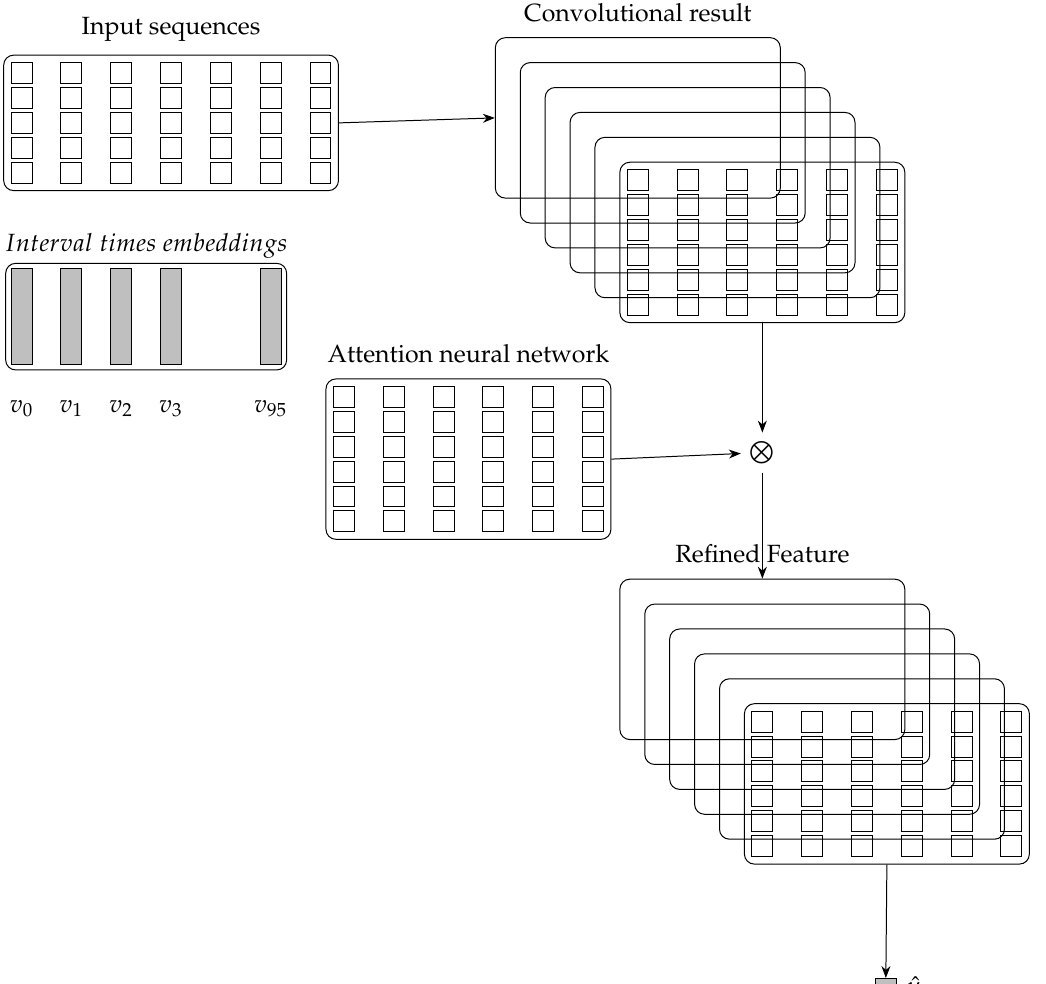
Figure 2. Architecture of the convolutional neural networks wich attention mechanism for travel-time